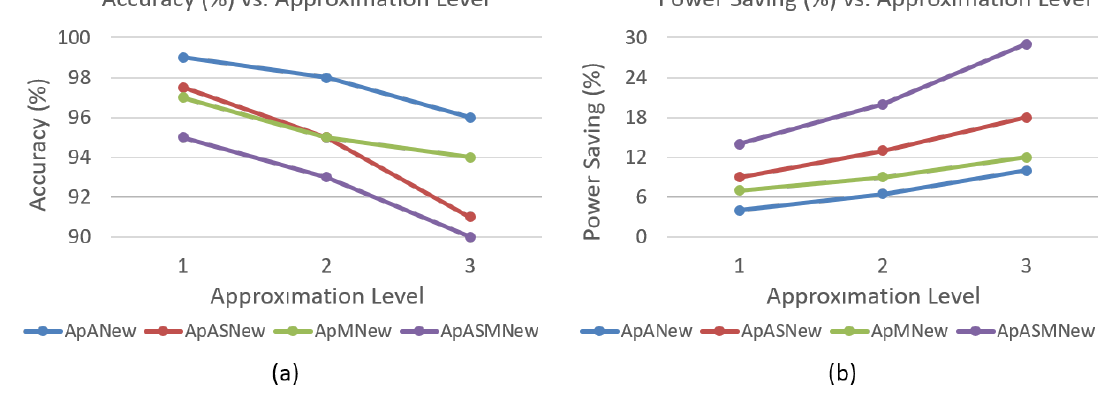
Figure 11. Approximation level modification at run-time ( a ) accuracy and ( b ) power saving results.